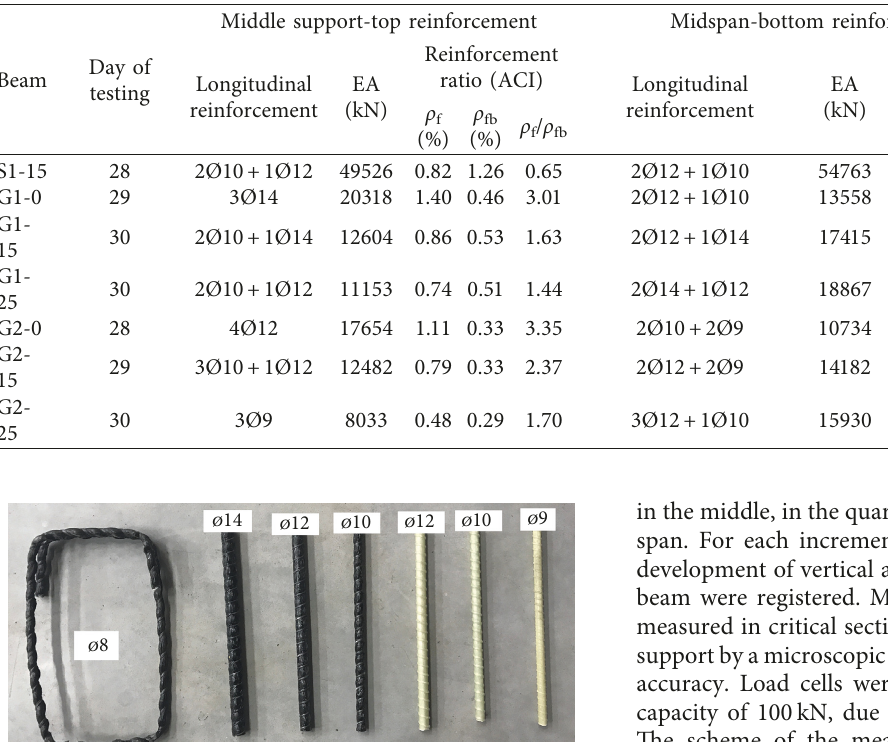
Table 1: Reinforcement details and compressive strength of concrete for tested beams.